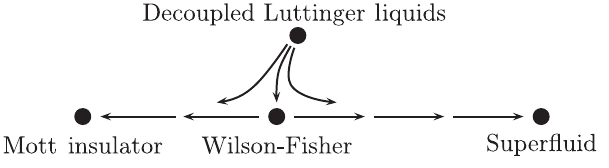
FIG. 5. Schematic RG flow of the bosonic wire model defined in Eq.